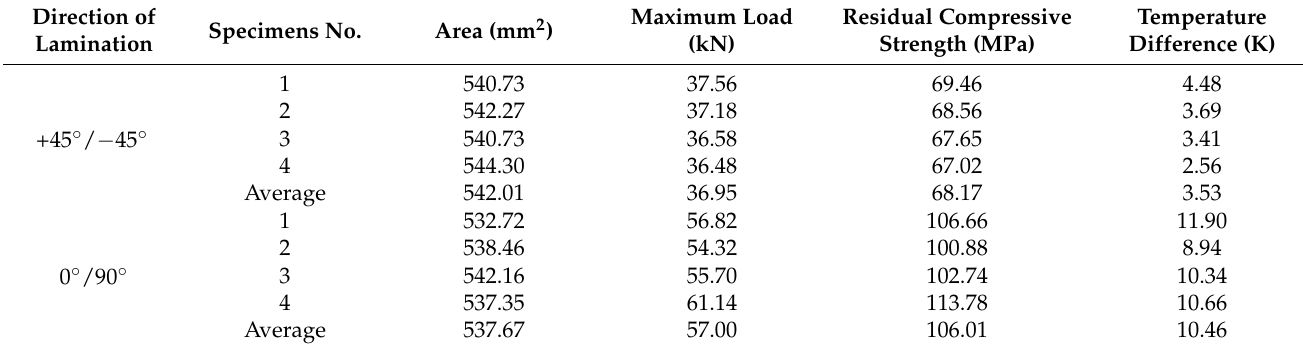
Figure 7. Load-displacement curve of the cai test (left) and thermal image of cai test (right): ( a , b ) specimen lamination in +45 ◦ / − 45 ◦ and ( c , d ) specimen lamination in 0 ◦ /90 ◦ . Table 5. CAI test results of specimen according to the lamination